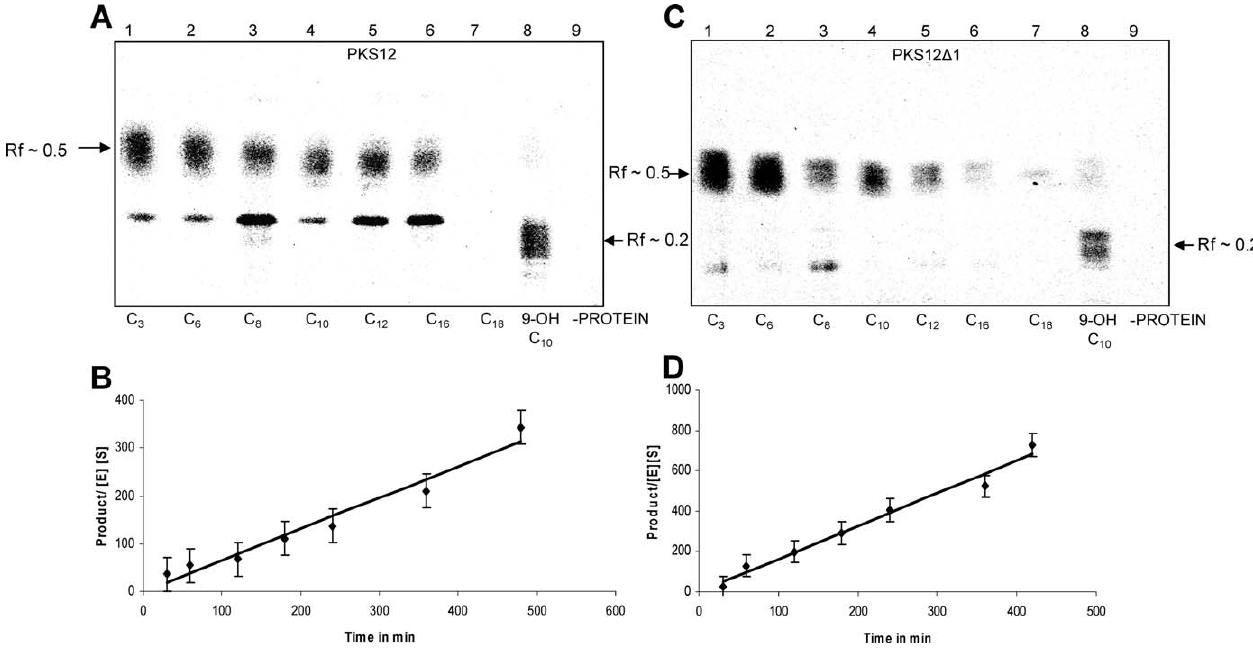
Figure 3. Biochemical Characterization of PKS12 and PKS12 D 1 Proteins (A)Radio-TLC characterization of PKS12 products. Lane 1 to 8 show the propionyl, hexanoyl, octanoyl, decanoyl, lauroyl, palmitoyl, stearoyl, and 9- hydroxy decanoyl N-acetyl cysteamine thioester primed products. No product is formed in the absence of protein (lane 9). (B) Time course of product formation catalyzed by PKS12 protein. The error bars correspond to three independent experiments, and the data points are an average of all three. (C) Radio-TLC characterization of PKS12 D 1 products. Lane 1 to 8 show the propionyl, hexanoyl, octanoyl, decanoyl, lauroyl, palmitoyl, stearoyl, and 9- hydroxy decanoyl N-acetyl cysteamine thioester primed products. No product is formed in the absence of protein (lane 9). (D) Time course of product formation catalyzed by PKS12 D 1 protein. The error bars correspond to three independent experiments, and the data points are an average of all